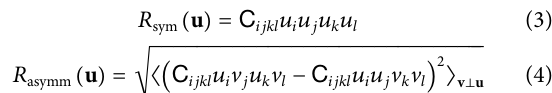
Frontiers in Physics |